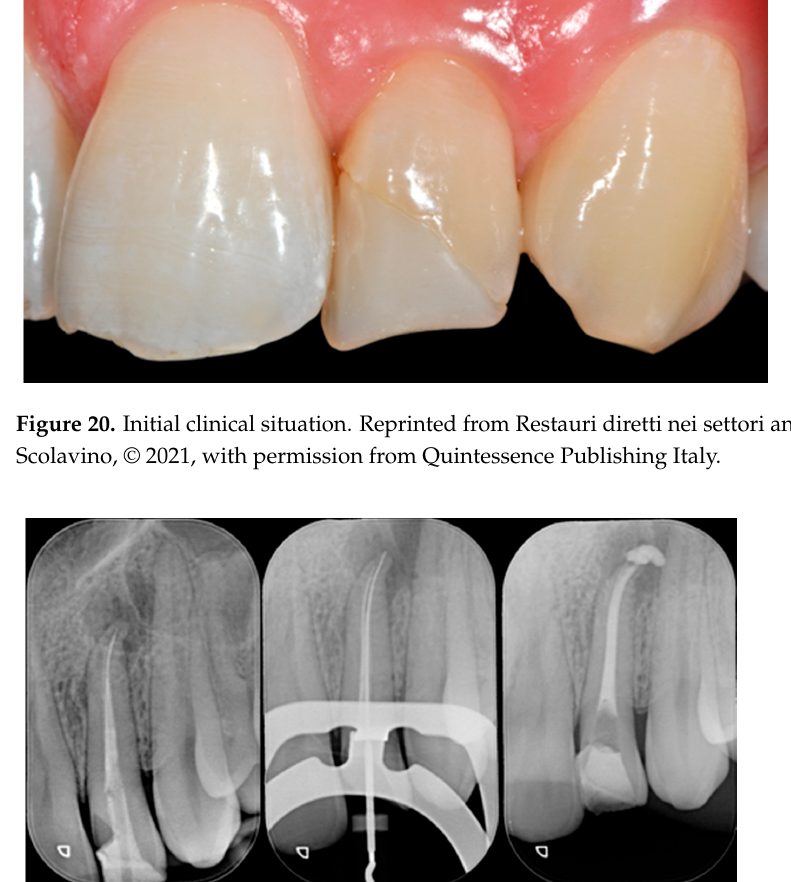
Figure 22. After isolation preparation is performed. Reprinted from Restauri diretti nei settori anteriori, G. Paolone, S. Scolavino, © 2021, with permission from Quintessence Publishing Italy.